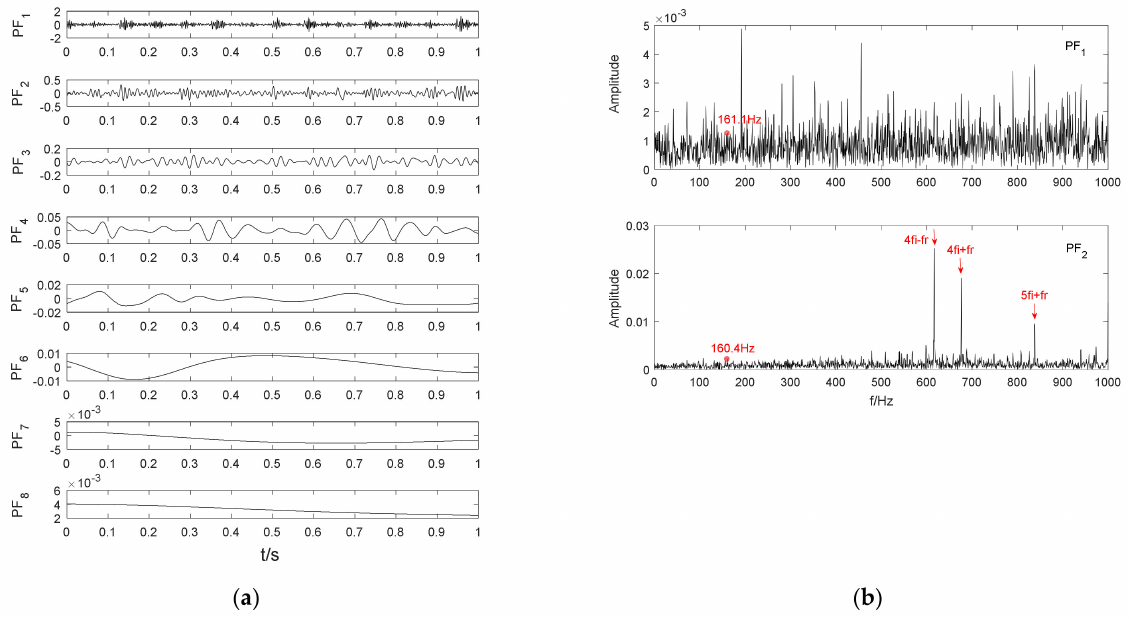
Figure 13. The decomposition results of LMD: ( a ) Time domain; ( b ) Frequency